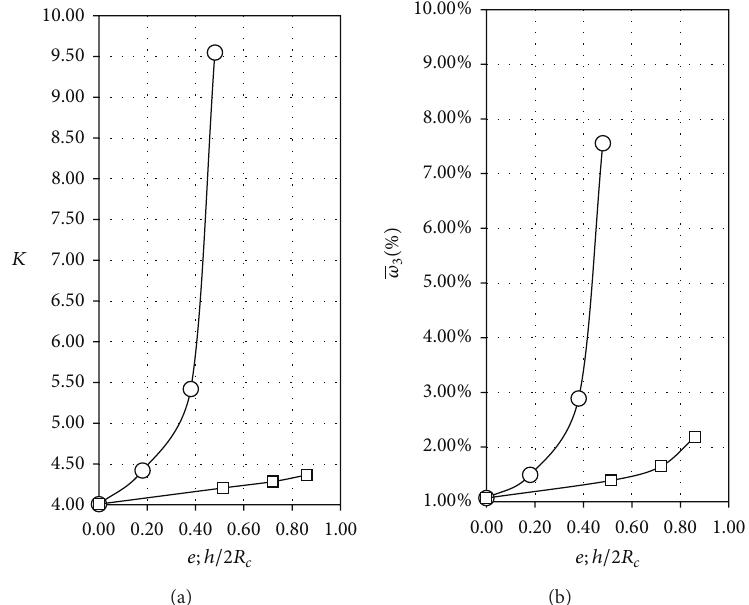
Figure 8: Anemometer constant at 16m/s wind speed, 𝐾 , and non-dimensional third harmonic, 𝜔 3 , with regard to the calibrations performed to the anemometer equipped with elliptical (squares) and porous (circles) cup rotors, as a function of the eccentricity, 𝑒 = √1 − (𝑏/𝑎) 2 , and the ratio of the hole diameter to the front cup area, ℎ/2𝑅 𝑐 ,